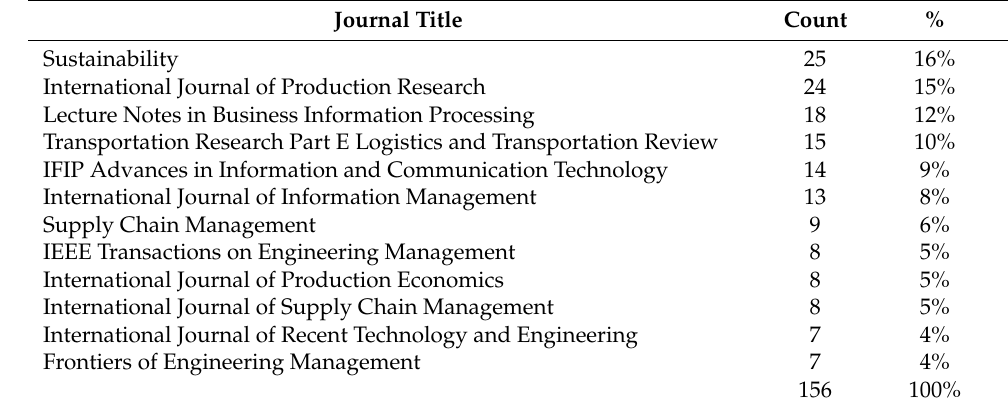
Table 2. Top ten journals in terms of number of